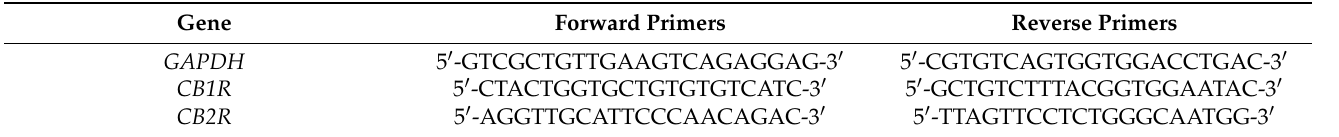
Table 1. PCR primer sequences used for the RT-PCR analysis of